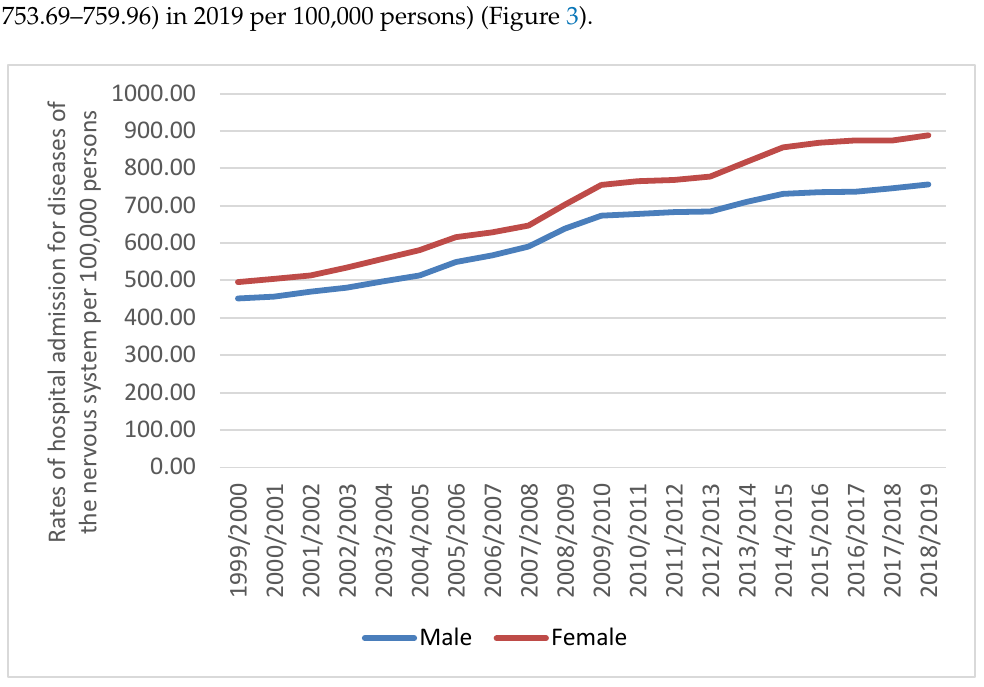
Figure 2. Rates of hospital admission for diseases of the nervous system in England and Wales stratified by age group.